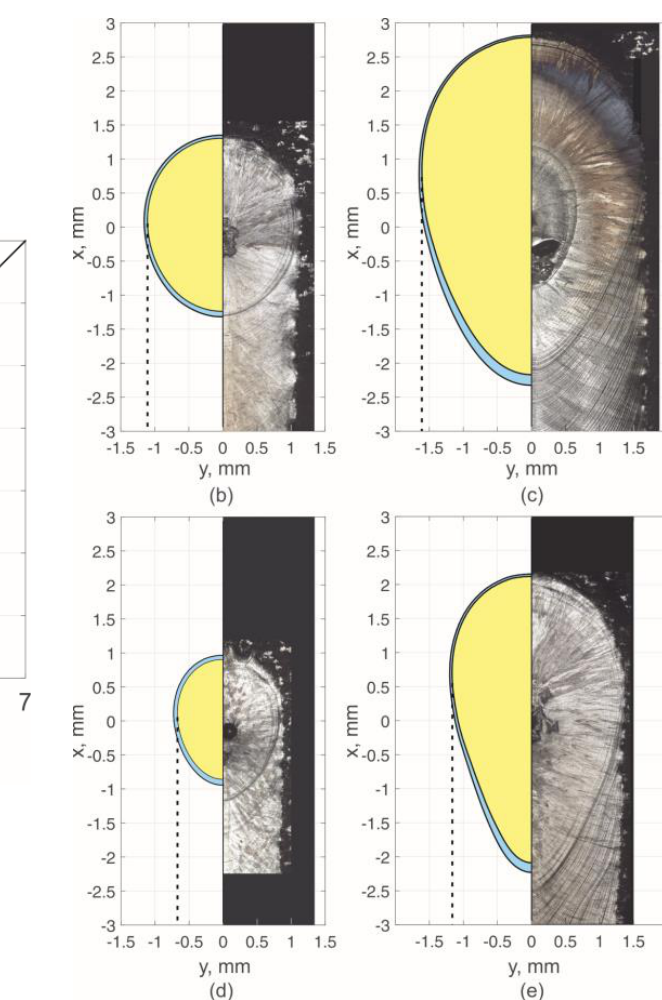
Figure 8. Experimentally measured dimensions of the melt pool and the corresponding calculated values: ( a ) comparison of expected and calculated values. Calculated (left) and experimental (right) form at: ( b ) 1000 W and 10 mm/s; ( c ) 2000 W and 10 mm/s; ( d ) 1000 W and 30 mm/s; ( e ) 2000 W and 30 mm/s. The yellow area corresponds to T > T liq , the blue area corresponds to T sol < T < T liq .